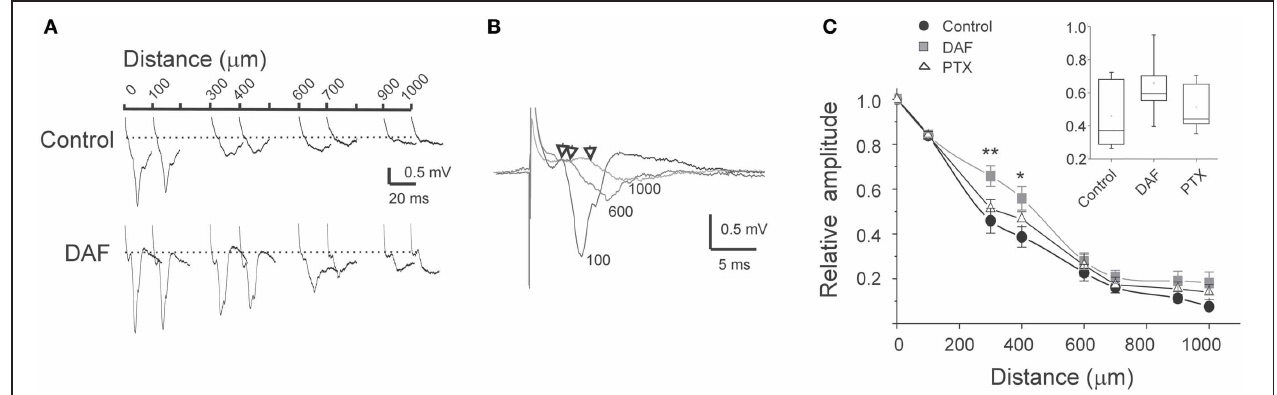
FIGURE 6 | The horizontal pattern of activity spread is affected by damage to NOS + interneurons. (A) Example traces of simultaneously recorded LFPs at the distances as marked above, in control slice and in DAF-treated slice. (B) Example traces from simultaneous recordings of LFPs at three distances from the center of activation (marked by the traces, in μ m). Arrows mark the deflection point from baseline. Note the short delay of